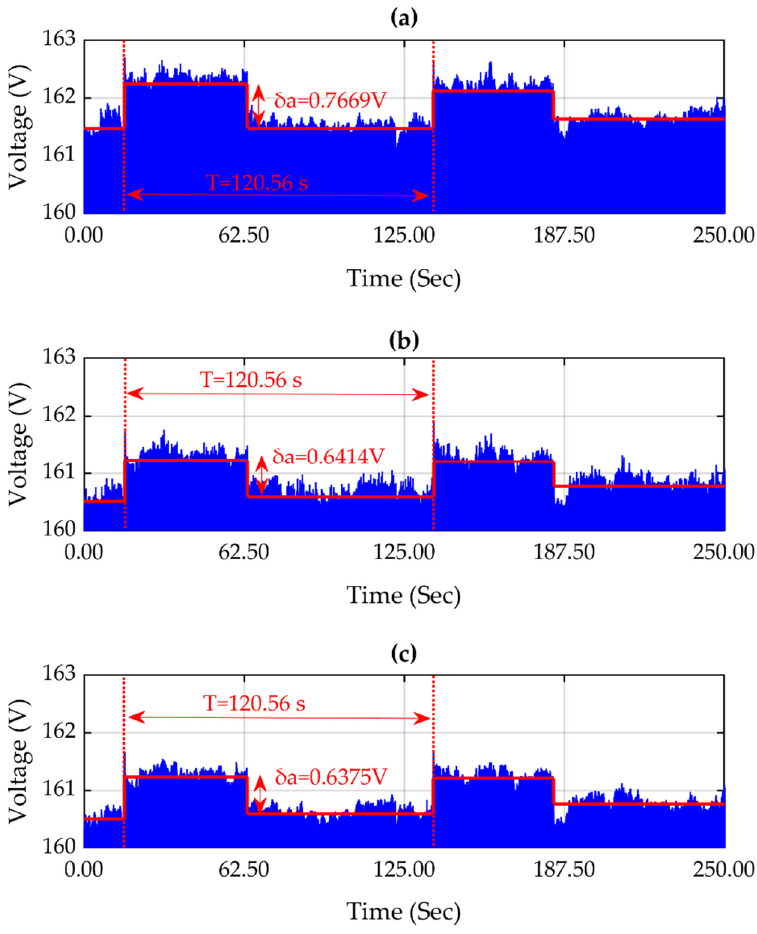
Figure 13. Signals ( a – c ) correspond to GPS synchronized data logger GSD-1, GSD-2, and GSD-3, and show a voltage fluctuation disturbance in voltage that propagates to three locations.